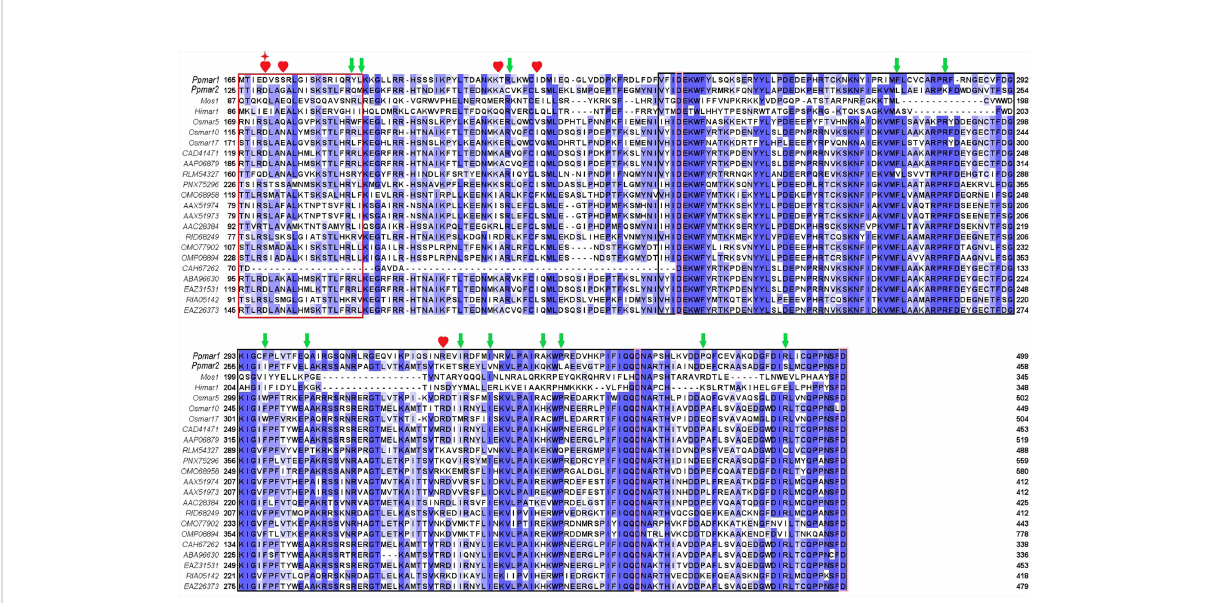
FIGURE 3 Homology alignment of 22 MLE transposases. The red box is the HTH domain, the black box is the DDD domain, and the Linker area is in the middle. Three aspartic acid residues (D) in the DDD domain were highlighted with pink boxes. Mos1 from D. mauritiana (Bryan et al., 1990), Himar1 from H. irritans (Robertson and Lampe, 1995), Ppmar1 from moso bamboo and three MLE transposases ( Osmar5, Osmar10, Osmar17 ) from rice (Yang et al., 2009). Other entries are named according to the fi rst letter of the genus name and the species name, followed by the GenBank accession number. The 12 non-conserved sites (marked by green arrows) of the Ppmar2 transposase were mutated into corresponding conserved amino acids. The 6 homologous hyperactive mutation sites in the Mos1 and Himar1 transposase were mutated into the corresponding amino acid in the Ppmar2 transposase (marked by a red heart shape). The amino acid at the 129 th position was mutated into two different amino acids (marked by a red star).